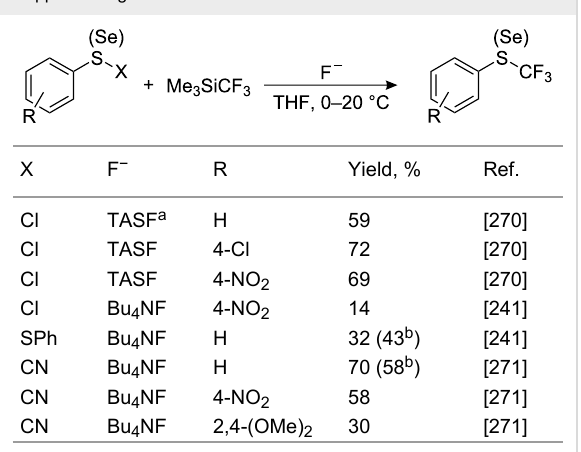
Table 17: Trifluoromethylation of sulfur and selenium compounds with Ruppert’s reagent.